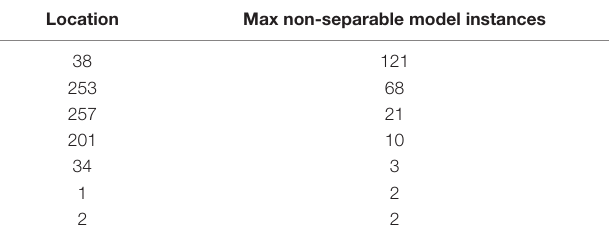
TaBle 5 | Optimal sensor